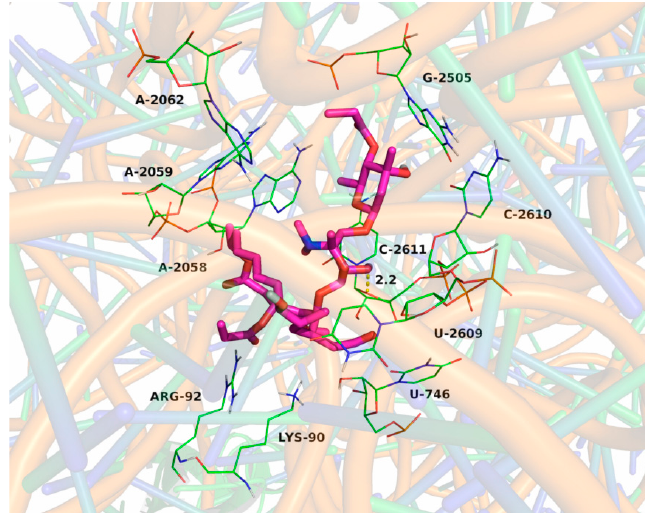
Figure 3. Detailed analysis of the binding mode between midecamycin A 1 and the ribosome. The ribosome is represented as a cartoon, and the representative binding nucleotides and amino acid residues are shown as lines. The midecamycin A 1 is represented by rose red sticks; while the hydrogen bonds are shown as yellow dotted lines.